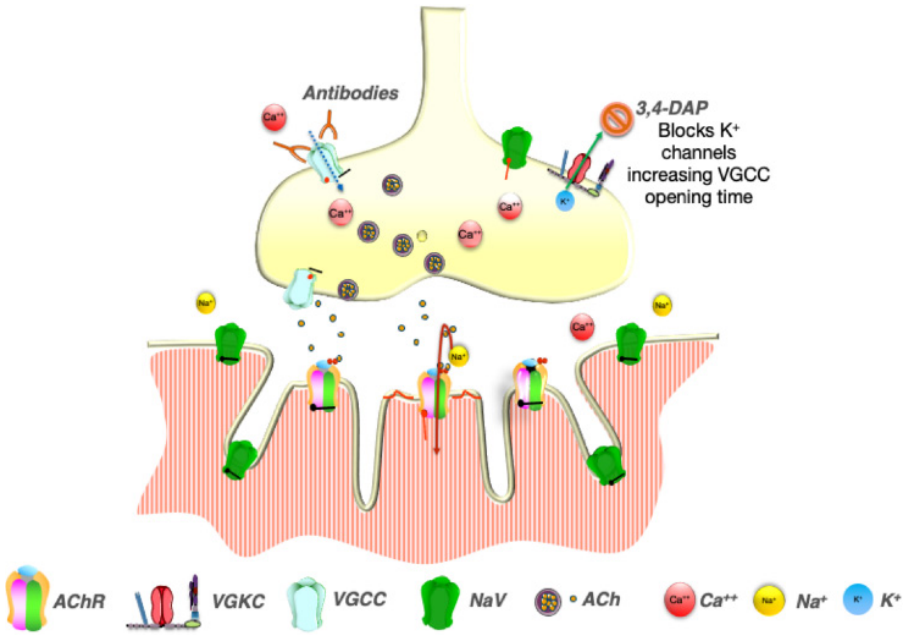
Figure 2. Effect of 3,4-diamniopyride treatment in LEMS. 3,4-diaminopyridine (3,4-DAP) blocks the efflux of potassium (K+) prolonging the presynaptic depolarization, which in turn prolongs the VGCCs opening time, allowing the influx of an increased amount of calcium ions with consequently increased ACh release.